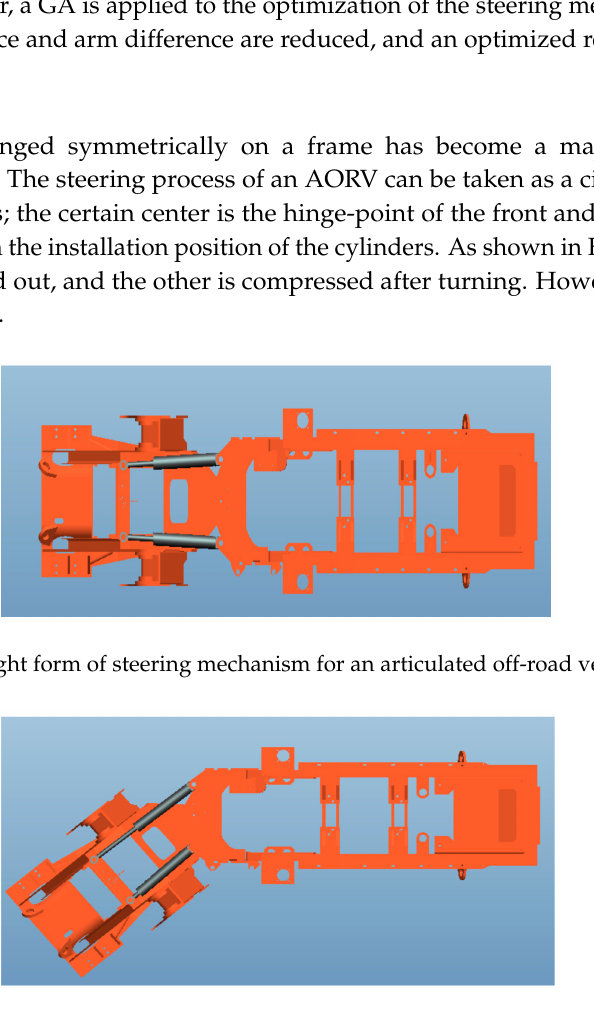
Figure 2. The turning form of steering mechanism for an